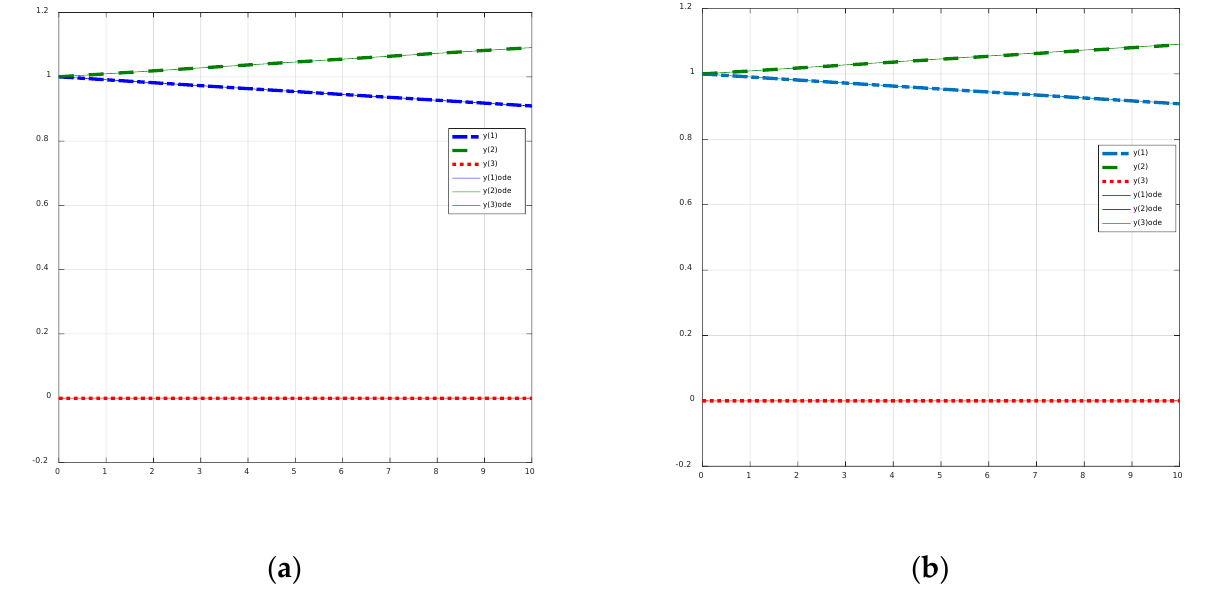
Figure 6. Graphical plots of Example 4 using the block hybrid methods with nfe = 500. ( a ) Solution curve of Example 4 using (18); ( b ) solution curve of Example 4 using (21). Example 5. Here, the present problem was solved by [35]. Therefore, for comparison, we present the graphical plots of this example in Figure 7, comparing with the exact solution curves. The application of the newly derived methods to this problem is to demonstrate their performance. However, we considered only the first four components { y 1 , y 2 , y 3 , y 4 } , as shown in Table 5.